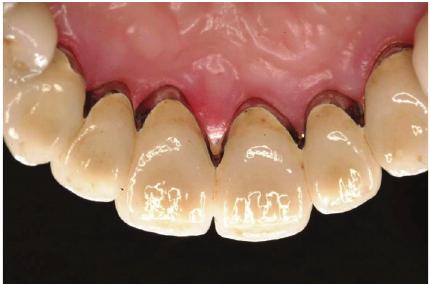
Figure 38: The occlusal scheme was designed with anterior guid- ance allowing a complete disclusion in both the lateral and protru- sive excursions.